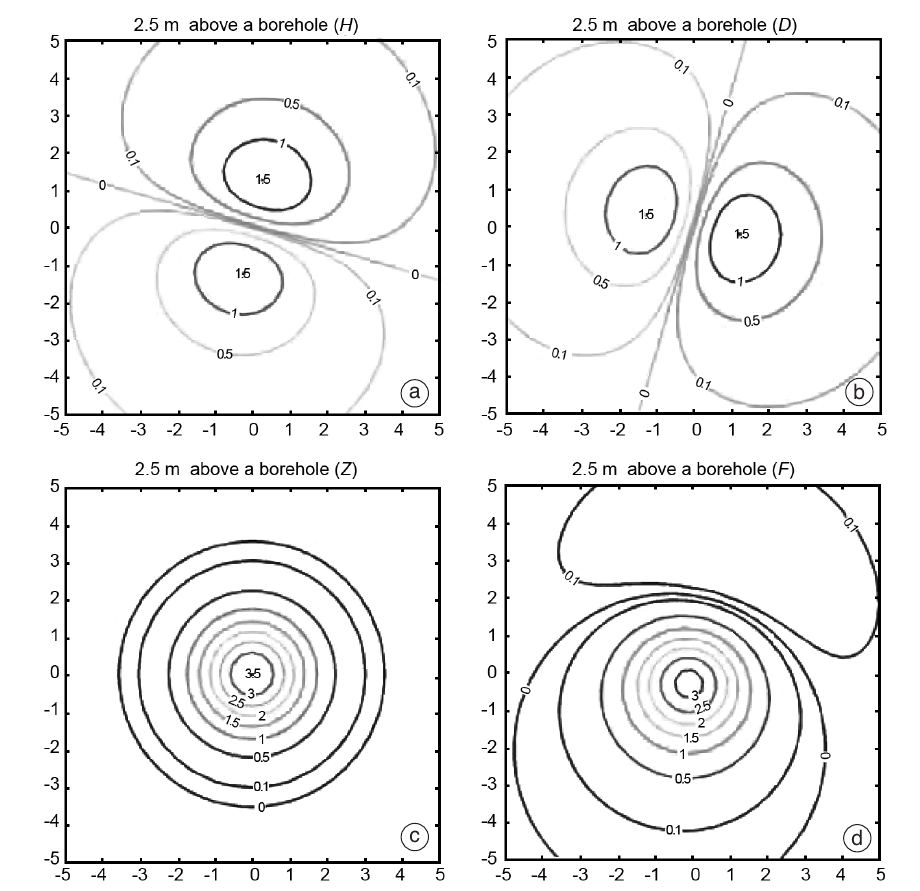
Fig. 4a-d. Four components of the piezomagnetic change due to a borehole: a) H , b) D , c) Z and d) F compo- nent. Each square shows 10 m × 10 m area of which center is the outlet of a borehole. Unit in